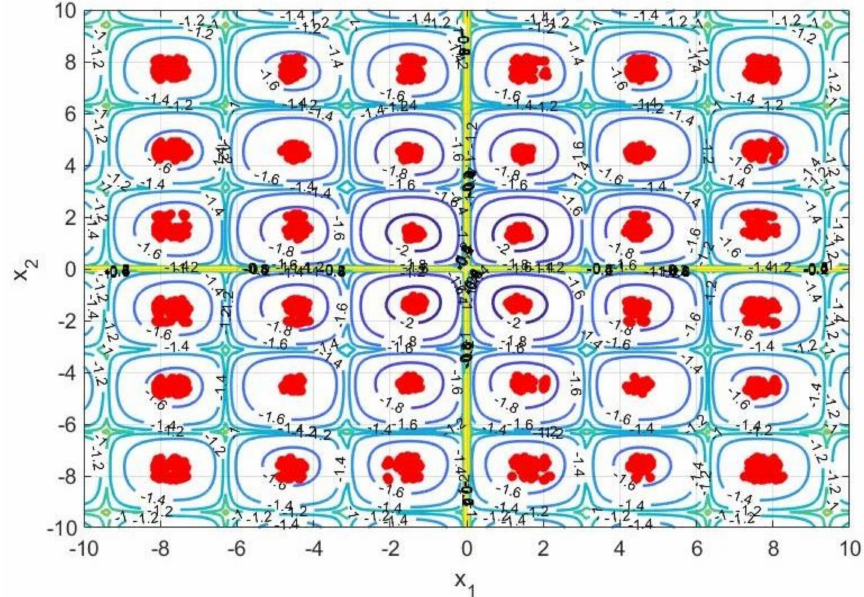
Figure 6. Cross-in-Tray Function 3D topography drawn by the proposed CSPSO and its correspond- ing 2D map of the local and global minima, with the confidence regions drawn by the deduced likelihood test. A surface map of the objective function is also presented in order to show the location and values of the